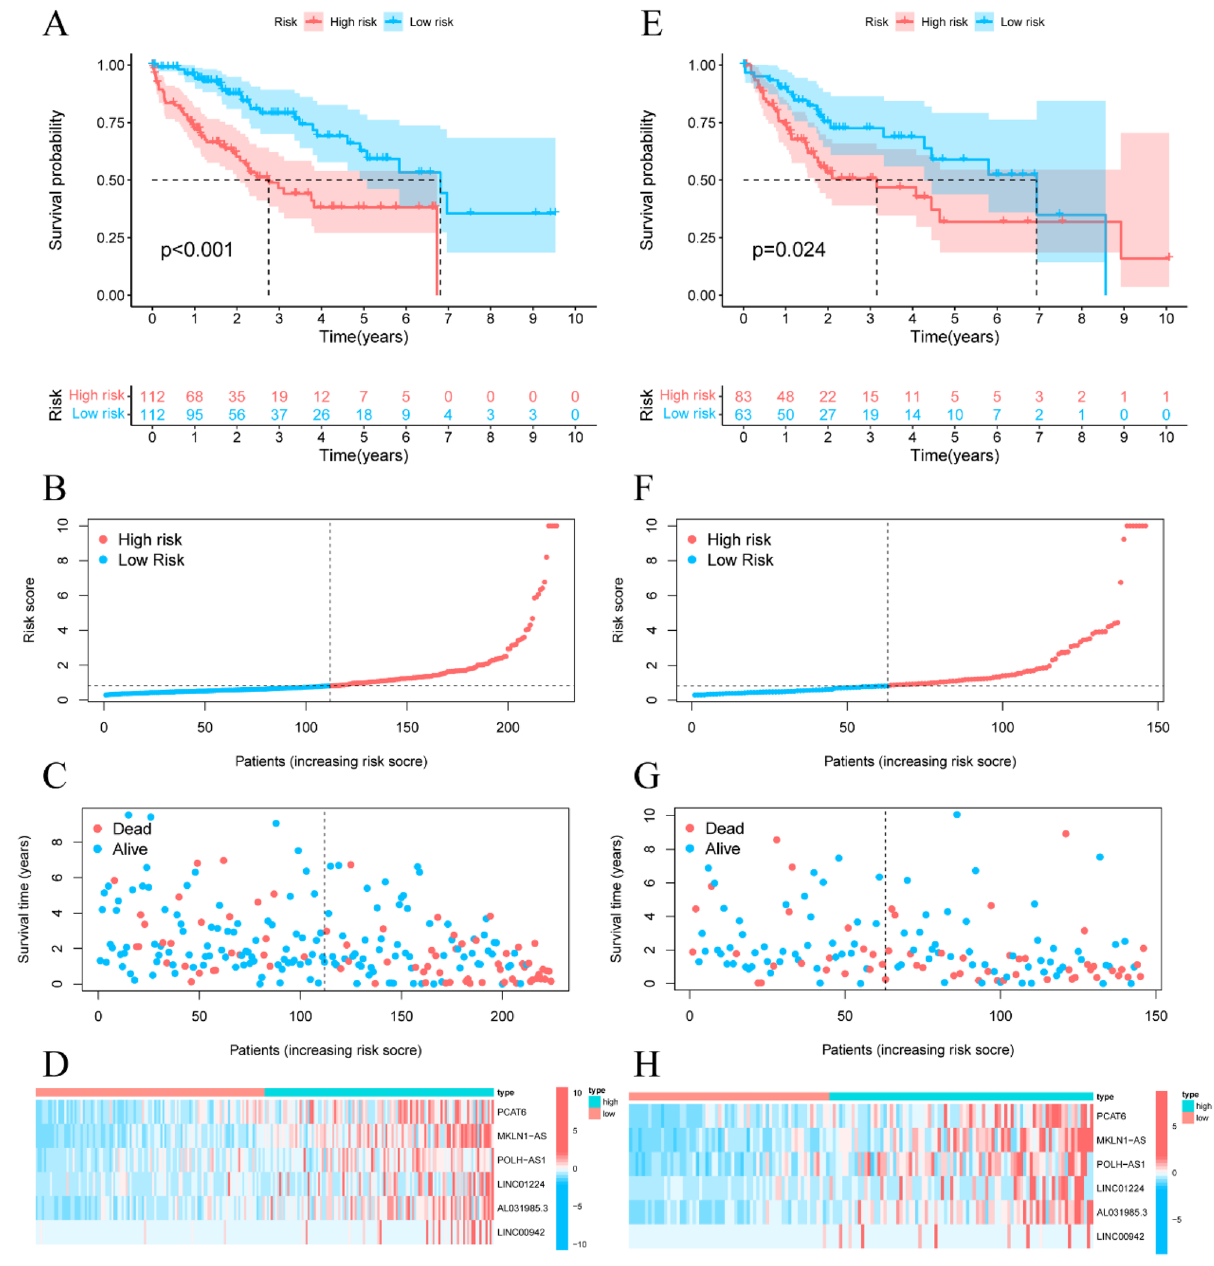
Figure 3. Prognostic signature of the riskScore analyses of the 6 ferroptosis-related lncRNAs in the TCGA training and testing sets. ( A ) Kaplan–Meier survival curves of the OS of patients were ranked by riskScore for the training set. ( B ) Distribution of ferroptosis-related lncRNA model-based riskScore for the training set. ( C ) Patterns of the survival time and survival status were ranked by riskScore. ( D ) Clustering analysis heatmap shows the display levels of the 6 lncRNA for each patient in the training set. ( E ) RiskScores ranked Kaplan– Meier survival curves of the OS of for the testing set. ( F ) Distribution of ferroptosis-related lncRNA model- based riskScore for the testing set. ( G ) Patterns of the survival time and survival status were ranked by riskScore. ( H ) Clustering analysis heatmap shows the display levels of the 6 lncRNA for each patient in the testing